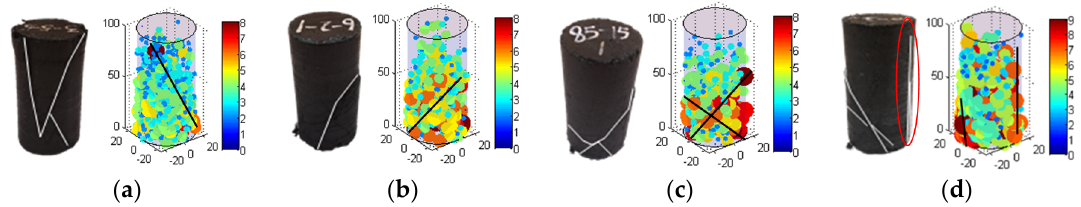
Figure 6. Destruction morphology and AE energy release spatial distribution of coal samples at different depths: ( a ) 300 m, ( b ) 600 m, ( c ) 850 m, and ( d ) 1050 m.